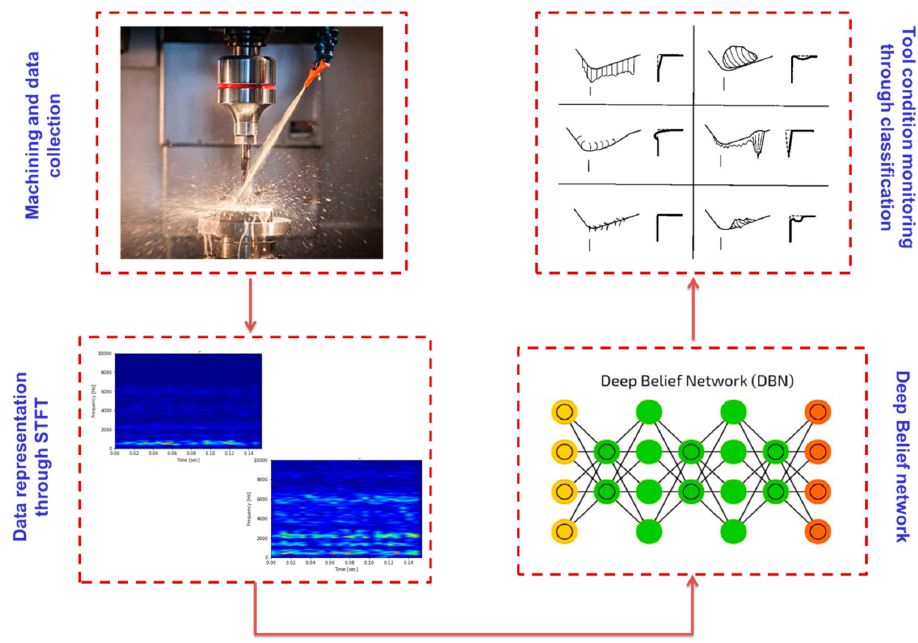
Figure 1. Step-wise organization of the current